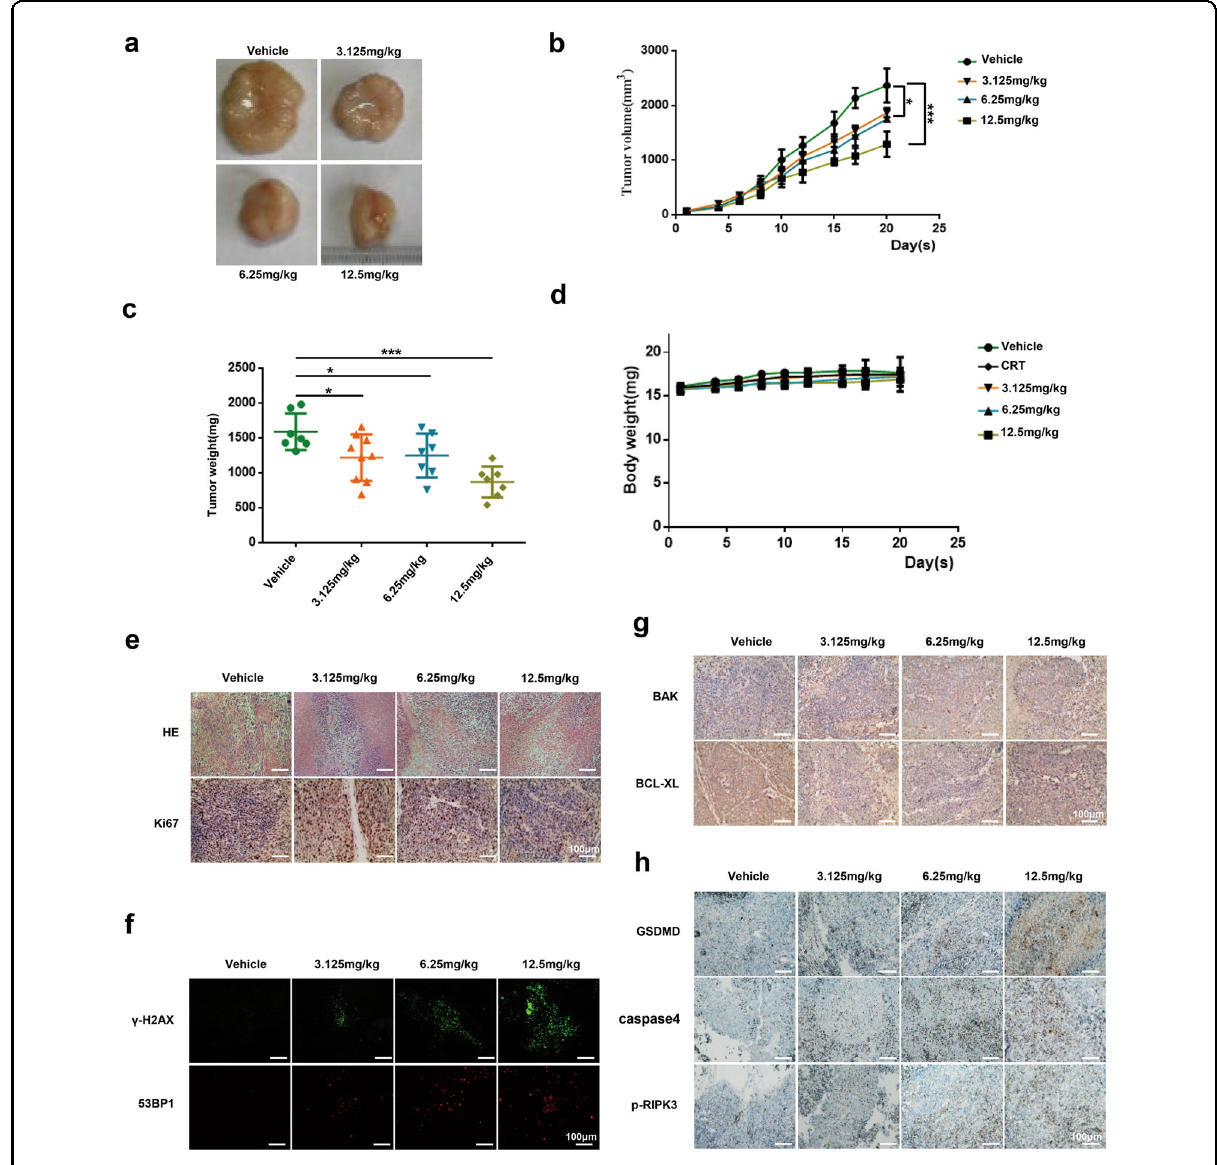
Fig. 5 NO.0449-0145 suppresses NSCLC xenograft tumors. a – c Tumor volumes and weights monitored from mice ( n = 5 per group) treated with vehicle or different dose of NO.0449-0145 (3.125, 6.25, and 12.5 mg/kg) every 2 days. d Mice body weights monitored during treatment. e Representative micrographs of H&E staining and IHC staining for Ki67. f Representative micrographs of Immuno fl uorescence staining for γ -H2AX and 53BP1 foci. g , h Representative micrographs of IHC staining for BAK, BCL-XL, GSDMD, caspase-4, RIPK3, and phosph-RIPK3. The signi fi cance between treated samples and control samples was determined using a t- test. * p < 0.05; *** p <